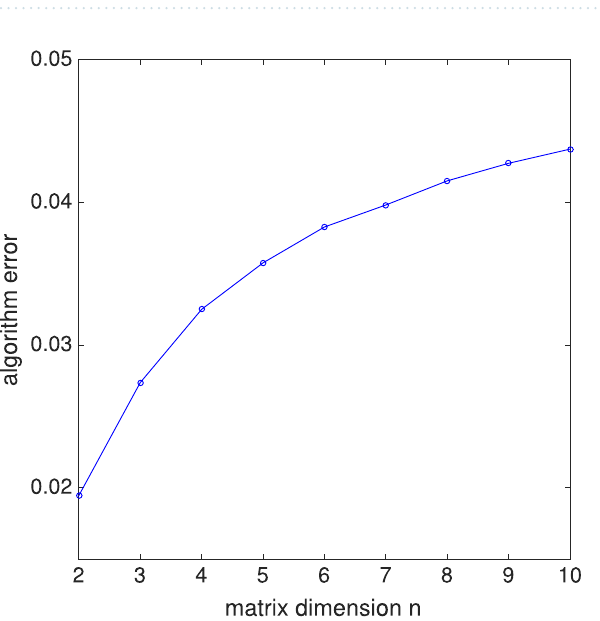
Figure 7. Matrix inversion algorithm error for m = 3 , averaged over random real symmetric matrices A (with eigenvalues 0 < (cid:31) i < 1 ). The error computed here results from the low precision of the phase estimation procedure (small m value) only and does not include the effects of decoherence and other errors that would arise during